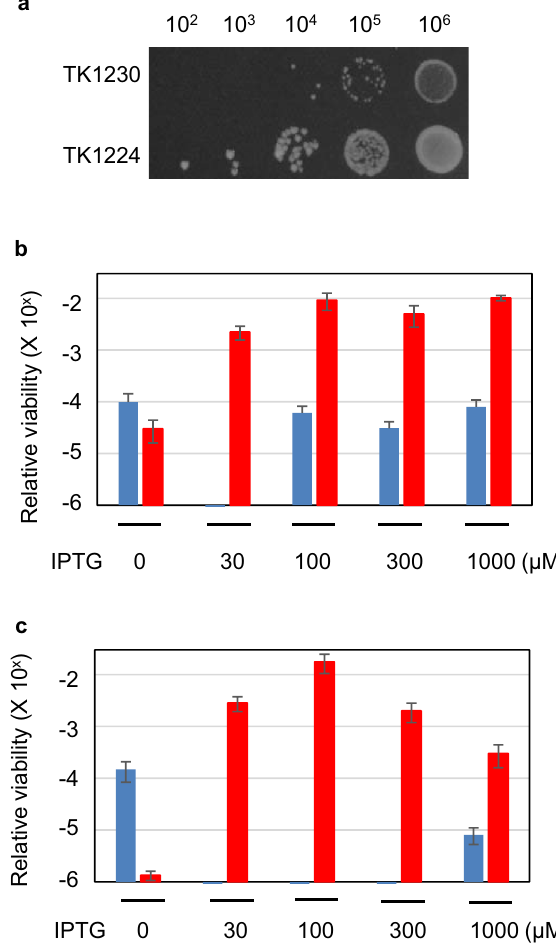
Figure 3. Effect of IPTG on ΔrecA306 polA25 cell viability. ( a ) Colony formation by ΔrecA306 polA25 cells. TK1230 ( ΔrecA306 polA p vec) or TK1224 ( ΔrecA306 polA p EXsrpC) cells were grown in M9GCAA medium and subsequently diluted with M9B to contain the indicated number of cell particles of either TK1230 or TK1224 cells. Next, 2 μL of diluted cells was spotted on LA plates and incubated at 30 °C for 3 days. ( b ) Effect of IPTG on relative viabilities of ΔrecA306 polA25 cells. Relative viabilities (RV) of TK1230 and TK1224 cells are shown with a bar graph. Cells were grown in M9GCAA medium. IPTG concentrations in the plates are indicated below. Cells were diluted with M9B from 10 4 to 10 7 cell particles/mL. Diluted cell cultures were spread on M9GCAA plates supplemented with various IPTG concentrations (indicated below). Viable cell counts were determined 5 days after cultivation at 30 °C. The results are shown as the mean ± SEM (n ≥ 3). TK1230: blue, TK1224: red. ( c ) Effect of IPTG on relative viabilities of ΔrecA306 polA25 cells from 30 μM IPTG seed culture. RVs of TK1230 and 1224 cells grown with 30 μM IPTG are shown with various concentrations of IPTG plates in the same manner as ( b